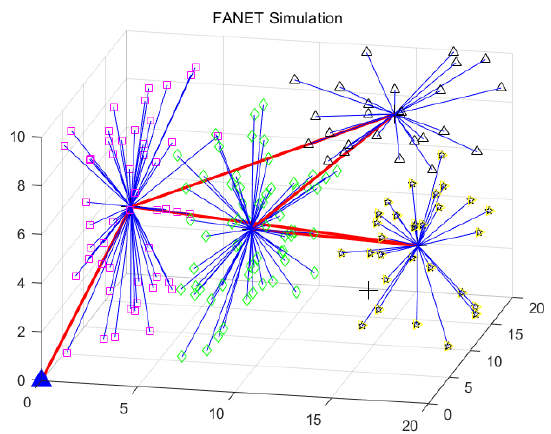
Figure 6. Visualization of the effect of clustering on UAV network.